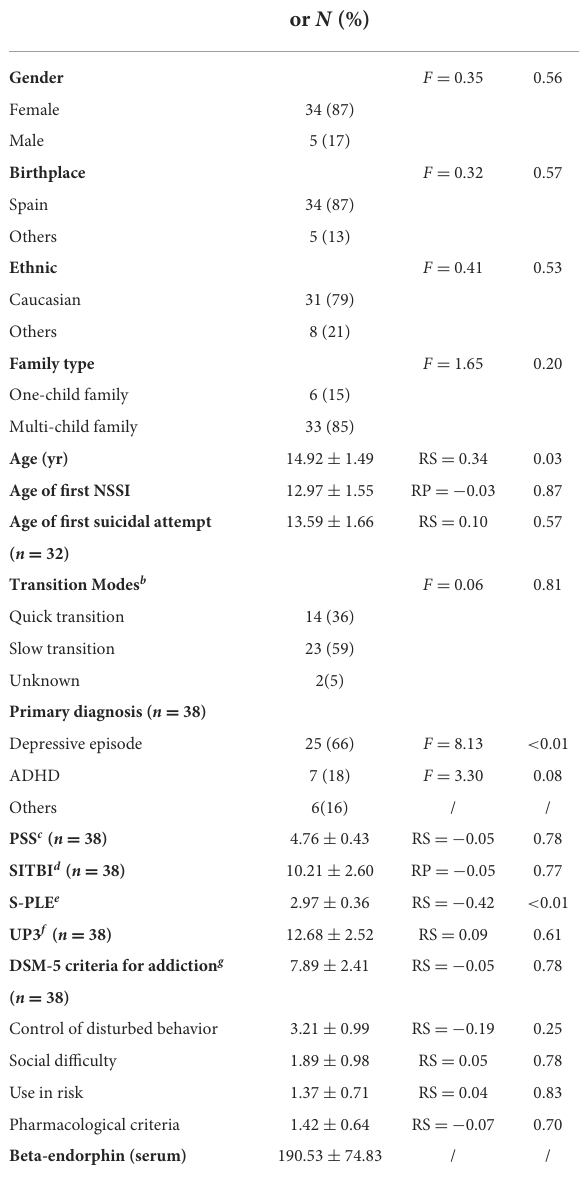
TABLE 1 Main features of the sample ( n =